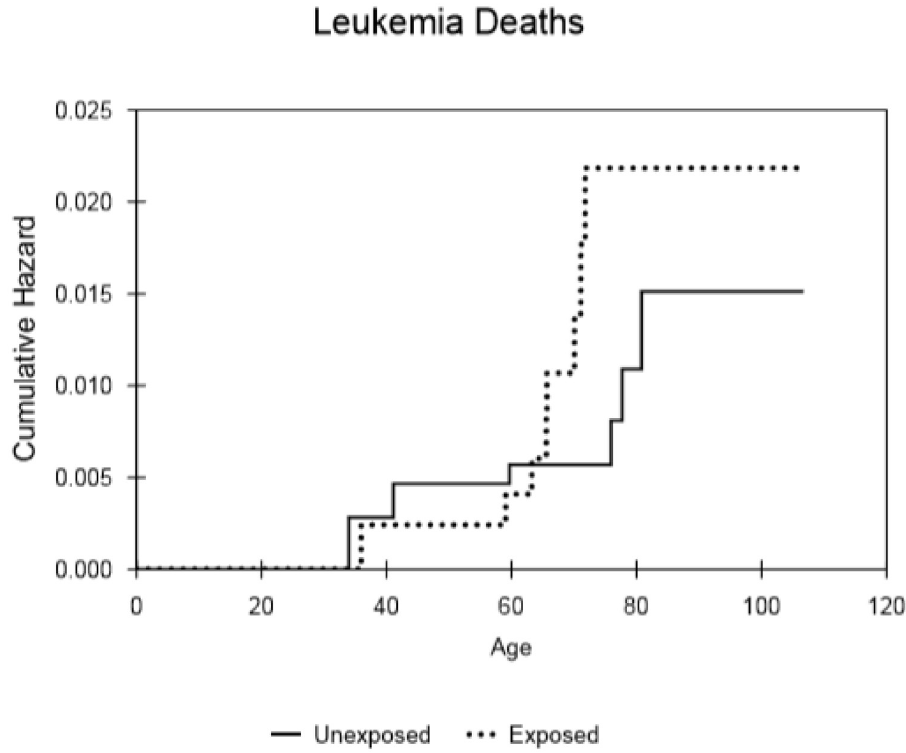
Fig 2. Cumulative hazard for all leukaemia types, within the selected populations of males that either received the typical dose or did not receive 224 Ra treatment, as a function of attained age.